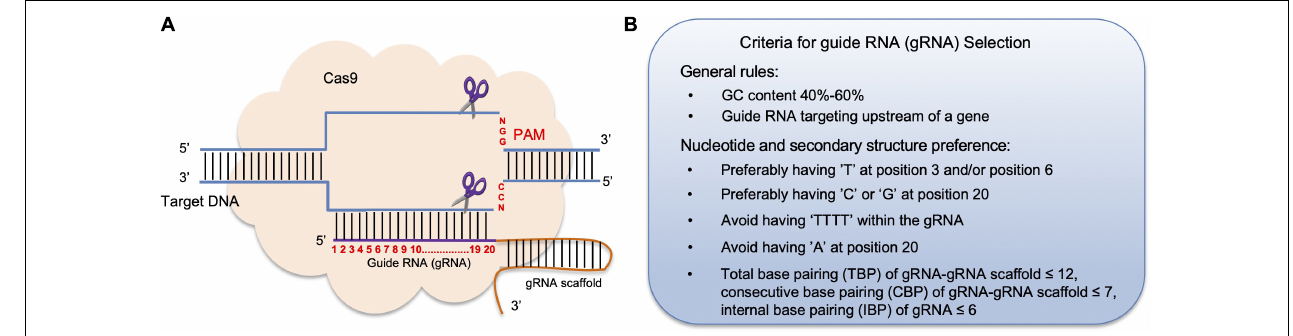
FIGURE 1 | The principle of CRISPR/Cas9 mediated genome editing and criteria for guide RNA selection. (A) In the CRISPR/Cas9 system, a 20 nt guide RNA (gRNA) is complementary to the target DNA region in the host genome followed by a gRNA scaffold sequence. Each target DNA sequence ends with a protospacer adjacent motif (PAM), which is often the sequence “NGG.” The formation of the gRNA-DNA complex triggers the binding of the Cas9 endonuclease to the complex and generates a double-stranded break (DSB) 3 bp in front of the PAM. (B) General rules for choosing a gRNA sequence to improve its effectiveness.